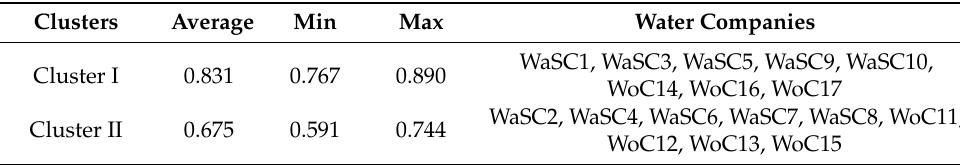
Table 5. Cluster analysis of eco-efficiency